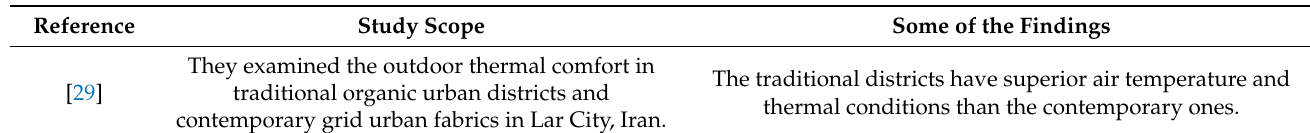
Table 2. Comparative studies between modern and traditional urban designs and